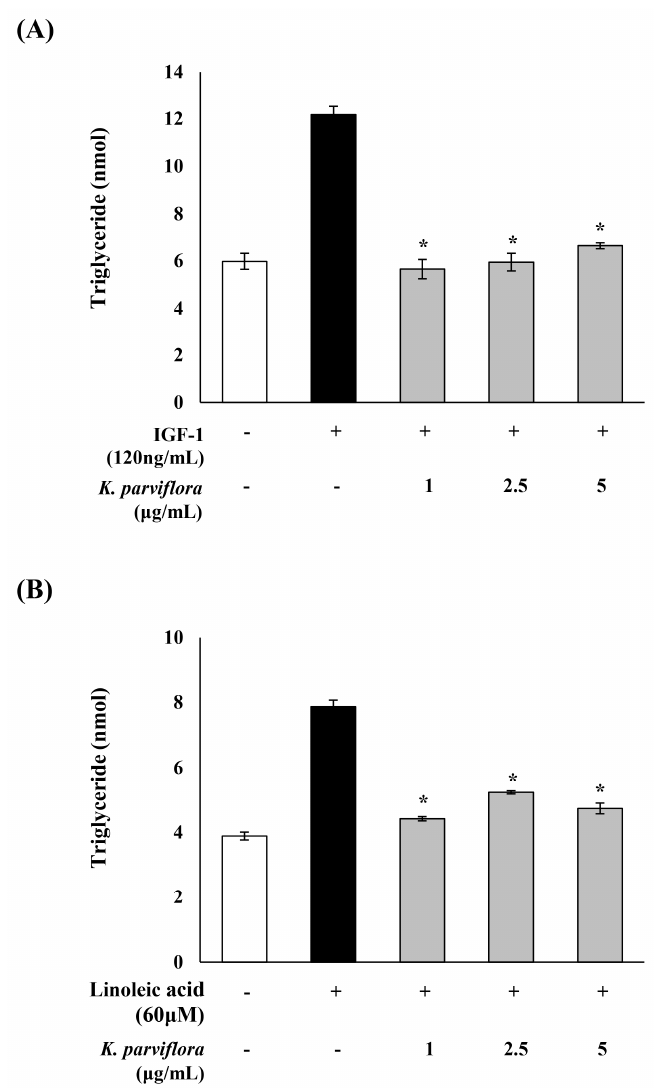
Figure 5. Effects of Kaempferia parviflora extract on ( A ) IGF-1- and ( B ) linoleic acid-induced lipogenesis. Triglyceride (TG) levels were analyzed by enzyme-linked immunosorbent assay (ELISA). All data are expressed as mean ± SD. * p < 0.05 compared to IGF-1 or linoleic acid treated cells only. Moreover, the LA-accumulated intracellular lipid was reduced in sebocytes treated with 5 µ g/mL K. parviflora extract (Figure 6A), as examined by oil red O staining. The IGF-1-induced expression of peroxisome proliferator-activated receptor gamma (PPAR- γ ) in sebocytes was also significantly inhibited by 5 µ g/mL K. parviflora extract (Figure 6B).